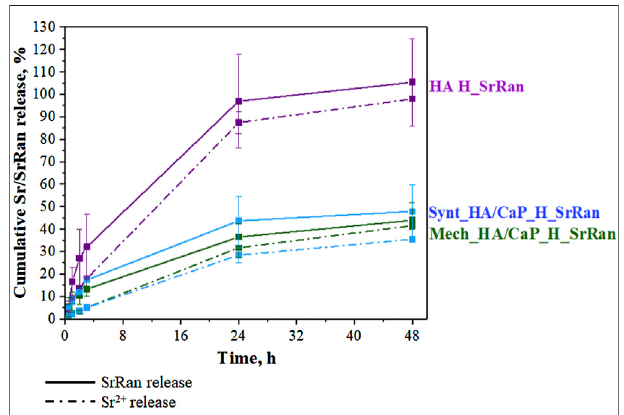
FIGURE 8 | Cumulative SrRan and Sr 2+ release during the neutralization process of